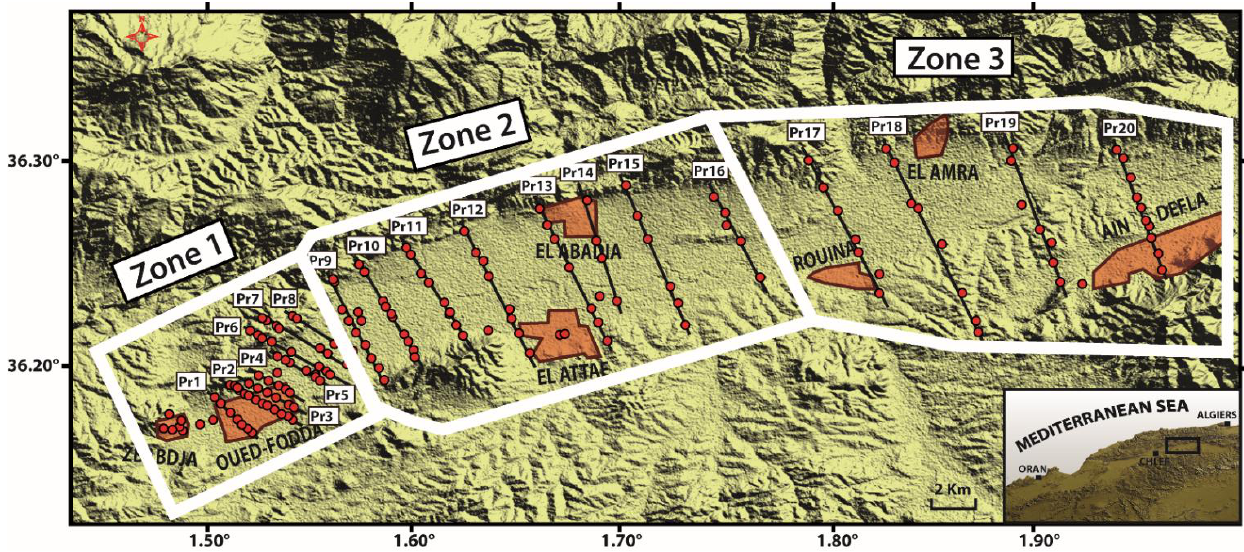
Figure 3. Zonation map of the study area. Red dots correspond to single-station measurements. Red polygons correspond to the limits of the different cities.